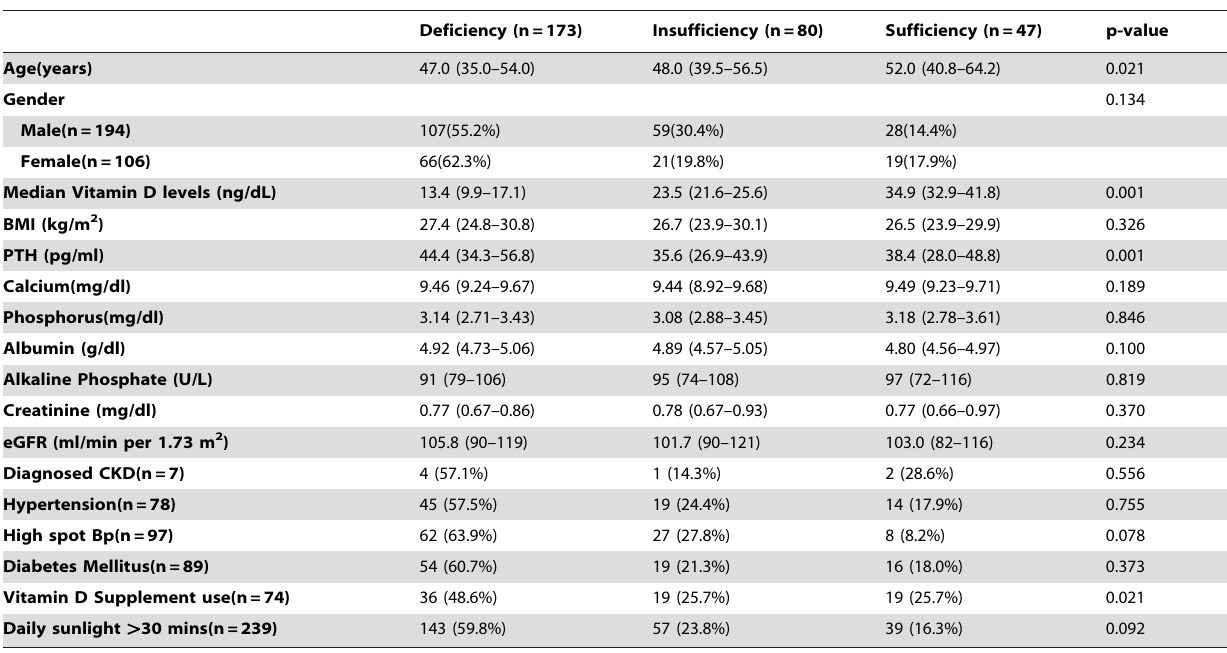
Table 1. Sample characteristics with respect to Vitamin D groups.